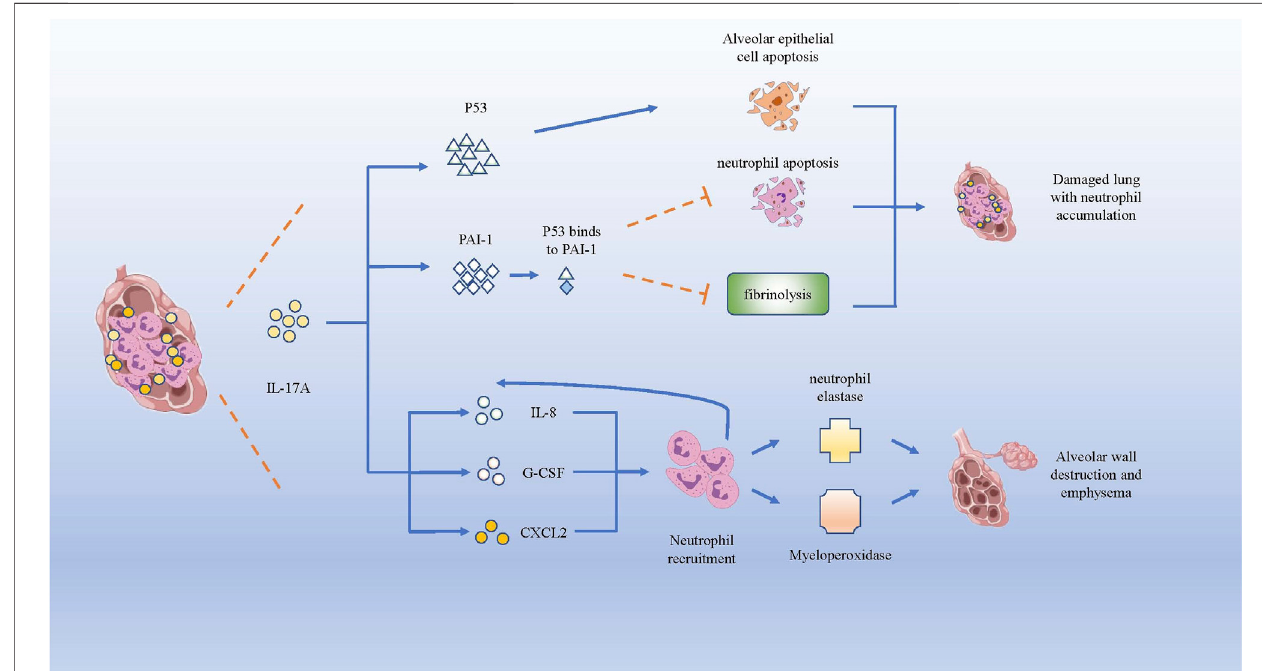
FIGURE 3 | IL-17A promotes neutrophils in fi ltration and lung destruction by increasing p53 and PAI-1. Both p53 and PAI-1 can induce the apoptosis of alveolar epithelial cells, while PAI-1 inhibits the neutrophil apoptosis and fi brinolysis in lung tissue. Besides, IL-17A induces the expression of IL-8, G-CSF and CXCL2, which recruits neutrophils producing neutrophil elastase and myeloperoxidase, giving rise to the destruction of alveolar wall and emphysema.